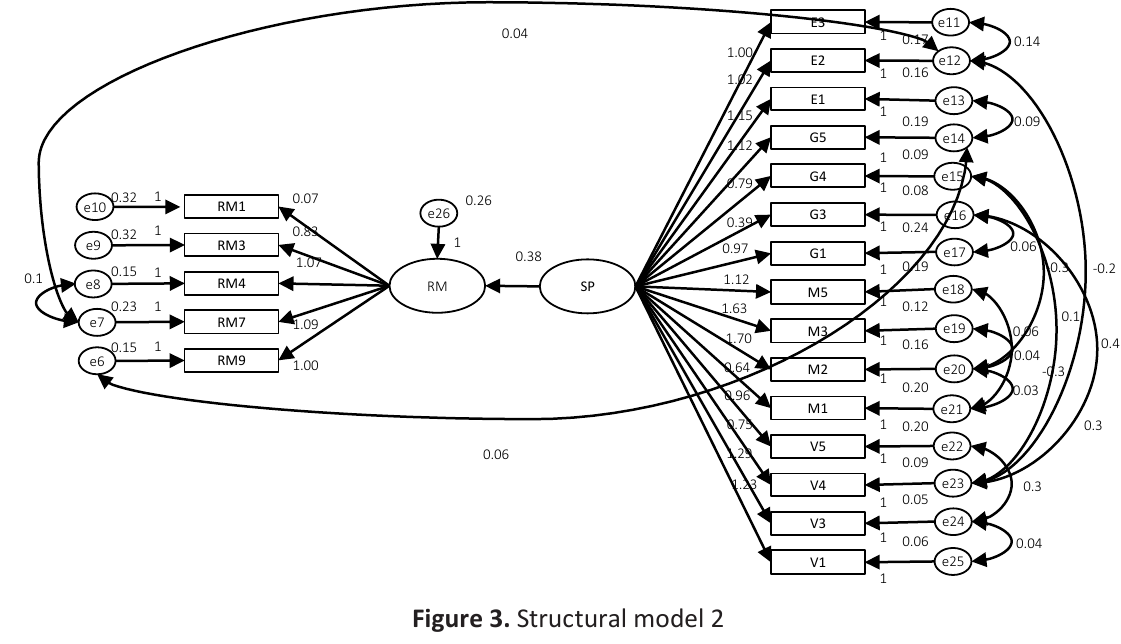
Figure 3. Structural model